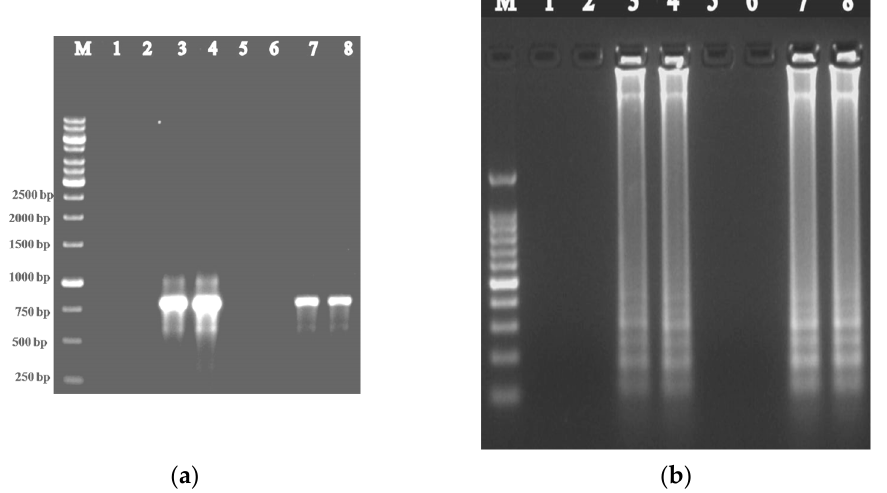
Figure 4. Agarose gel showing the amplification of ToLCNDV-Rg-CP gene from non-immunocaptured and immunocaptured plant samples using ToLCNDV- CP specific primers through ( a ) IC-PCR and ( b ) IC-LAMP assays. Lane M: 1 Kb DNA marker; Lanes 1 and 5: Water control; Lanes 2 and 6: Healthy samples; Lanes 3 and 4: Infected ridge gourd samples; Lanes 7 and 8: Infected immunocaptured ridge gourd samples.